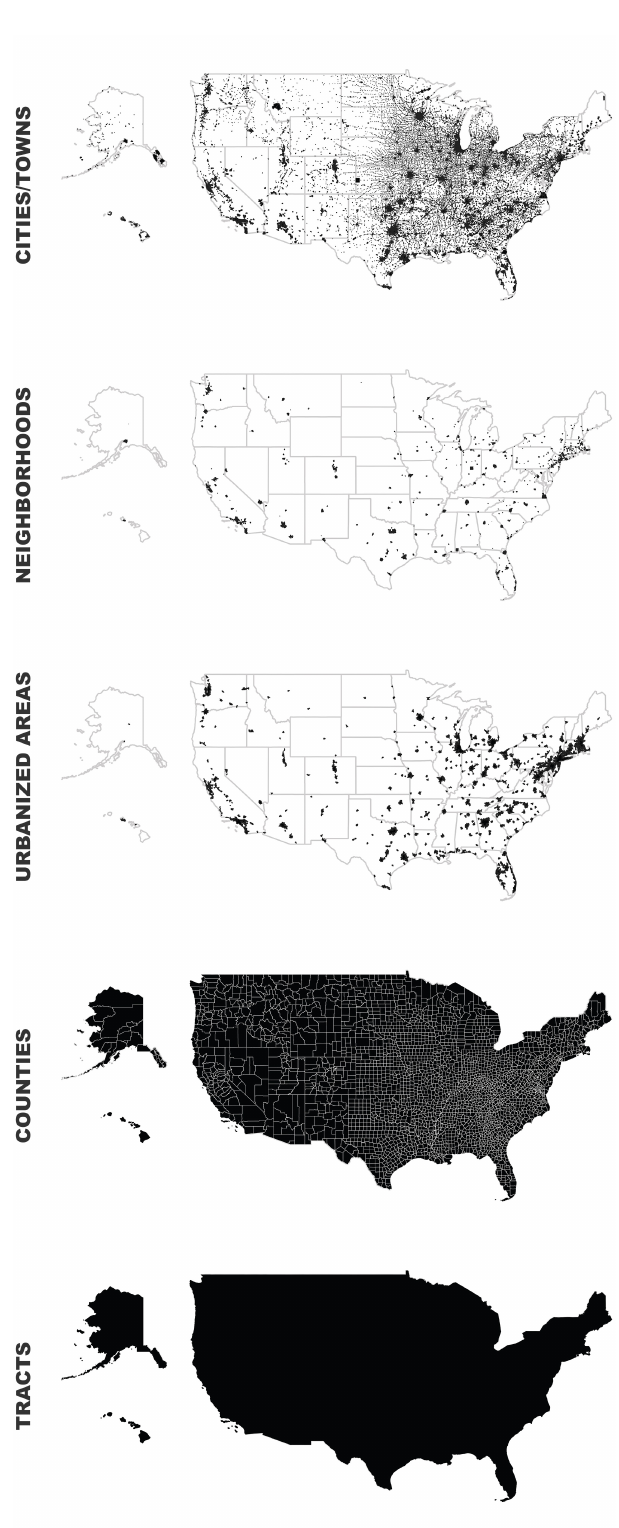
Figure 1. The dataset’s study sites’ coverage (black): 19,678 cities/towns, 17,037 Zillow-defined neighborhoods, 497 urbanized areas, 3233 counties, and 74,133 census tracts. Alaska and Hawaii not to